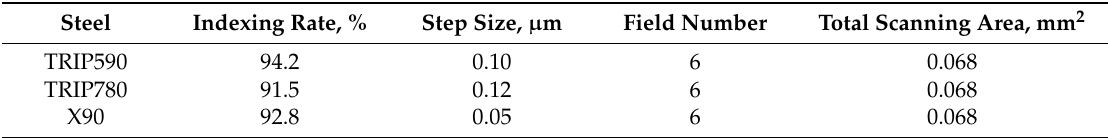
Table 8. The test parameters for analyzing retained austenite in three steels.